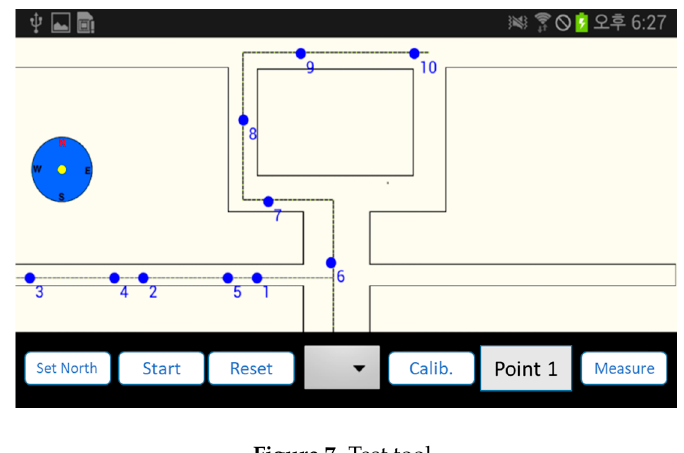
Figure 7. Test tool.